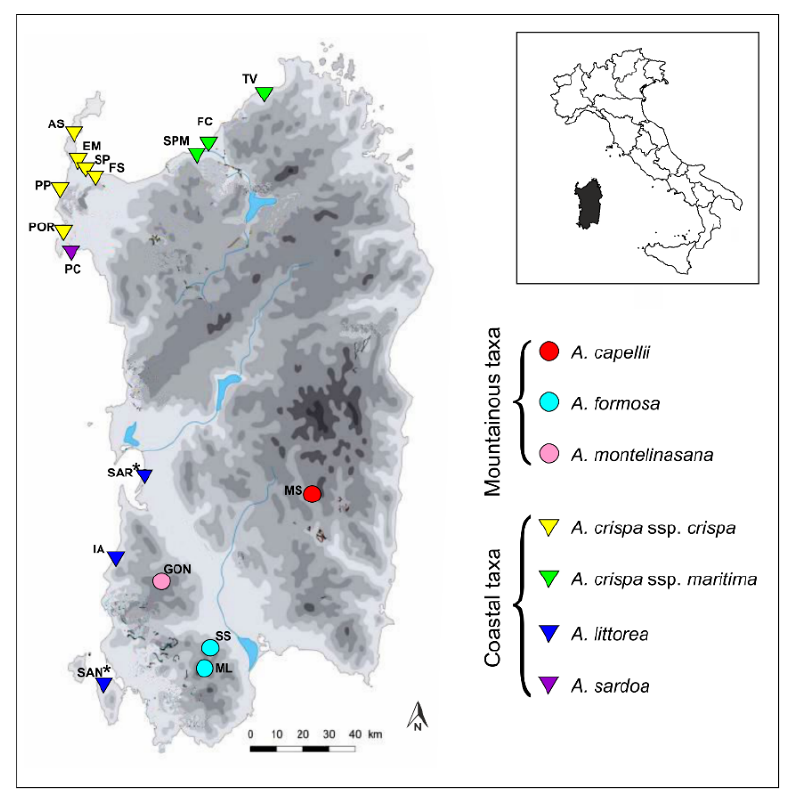
Figure 4. Populations of the Anchusa taxa analyzed in this study. * Extinct